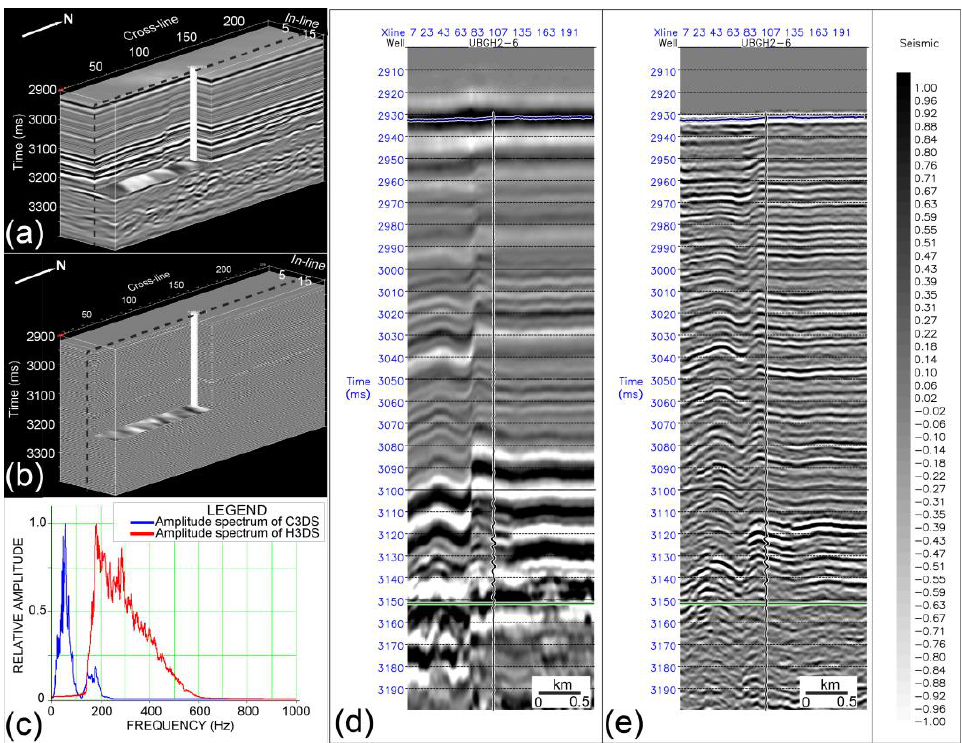
Figure 2. Two different 3D seismic datasets used in this study consist of 19 inlines (20 m interval) by 240 crosslines (10 m interval). ( a ) and ( b ) show rebinned CS3D and HS3D volume, respectively. ( c ) CS3D and HS3D amplitude spectra. ( d ) and ( e ) show seismic inline 13 of CS3D and HS3D crossing the UBGH2-6 well, respectively.